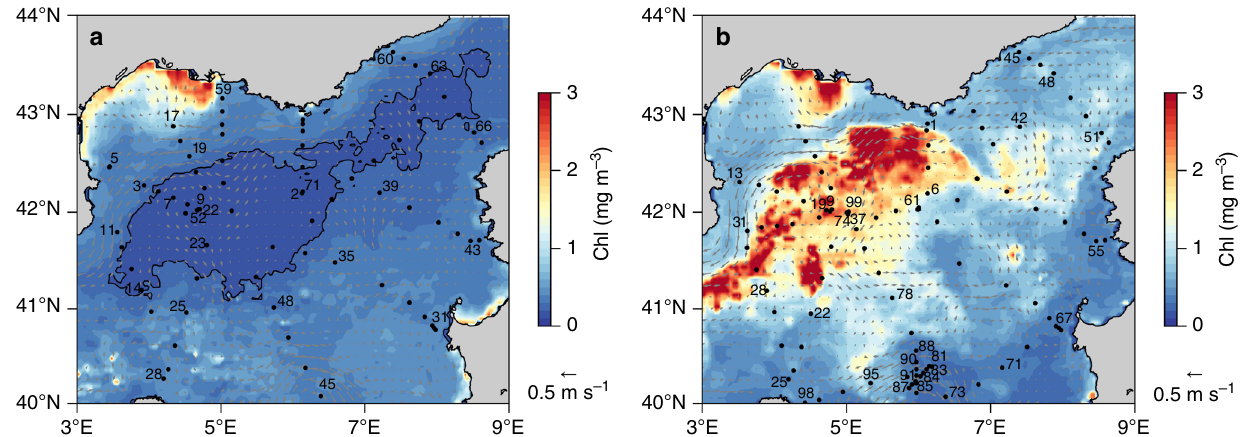
Fig. 1 Surface chlorophyll and geostrophic circulation during DeWeX in the North Western Mediterranean Sea. Images are averages of eight days composites for both satellite-derived chlorophyll a and geostrophic velocities (in m s − 1 ) over time periods corresponding to the DeWeX cruises ( a ) leg 1 (03 – 21 February 2013) and ( b ) leg 2 (05 – 24 April 2013) with a resolution of 4 km. Black dots correspond to CTD (conductivity temperature depth) casts. The black contour line shows the impoverished area with Chlorophyll a (Chl a ) during leg 1 (<0.2 mg Chl a m − 3 ) and indicates the location of the winter deep convection area, which extended until the sea fl oor (2400 m) in 2013. Station numbers are labeled where discrete phytoplankton samples